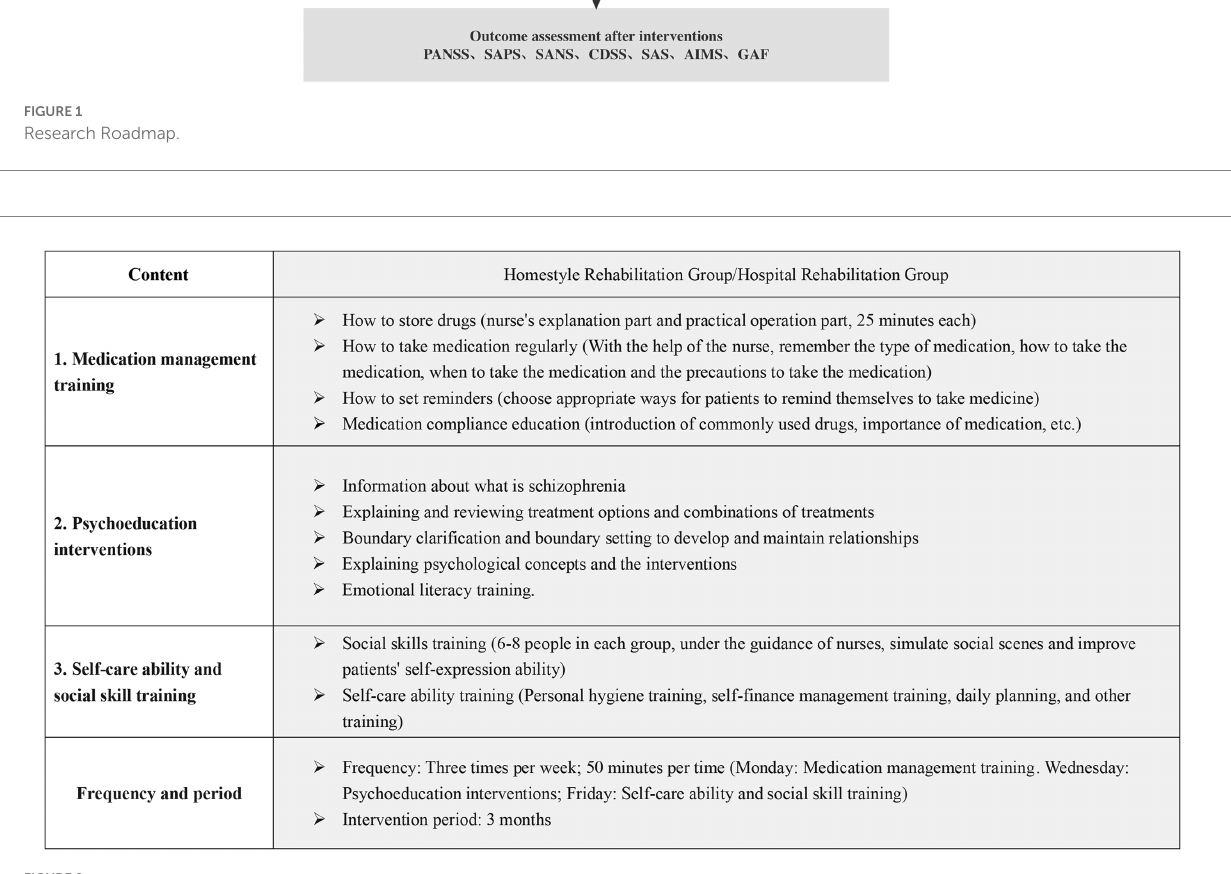
FIGURE 2 Intervention Plan